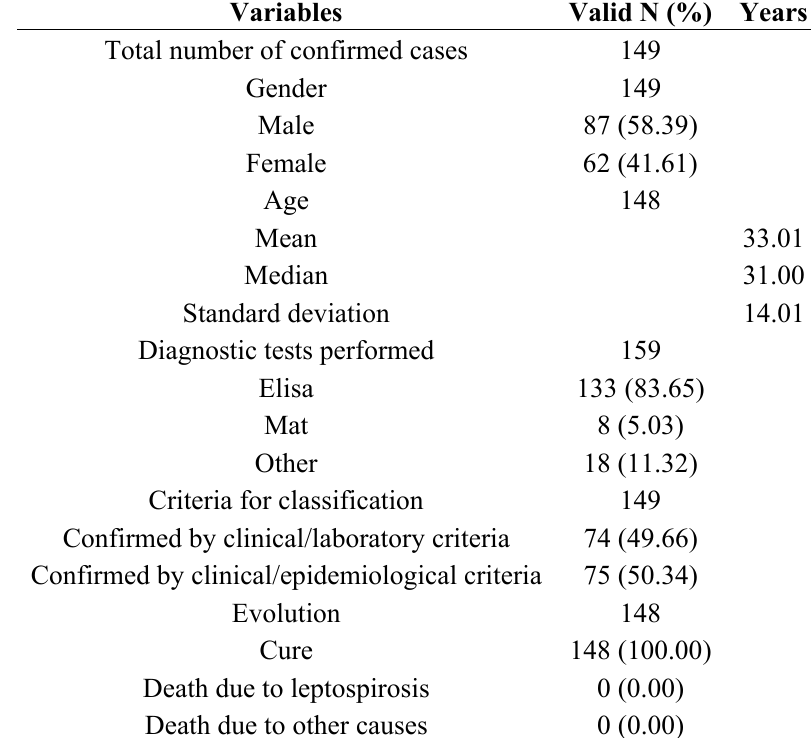
Table 2. Descriptive statistics of outpatient leptospirosis cases in Nova